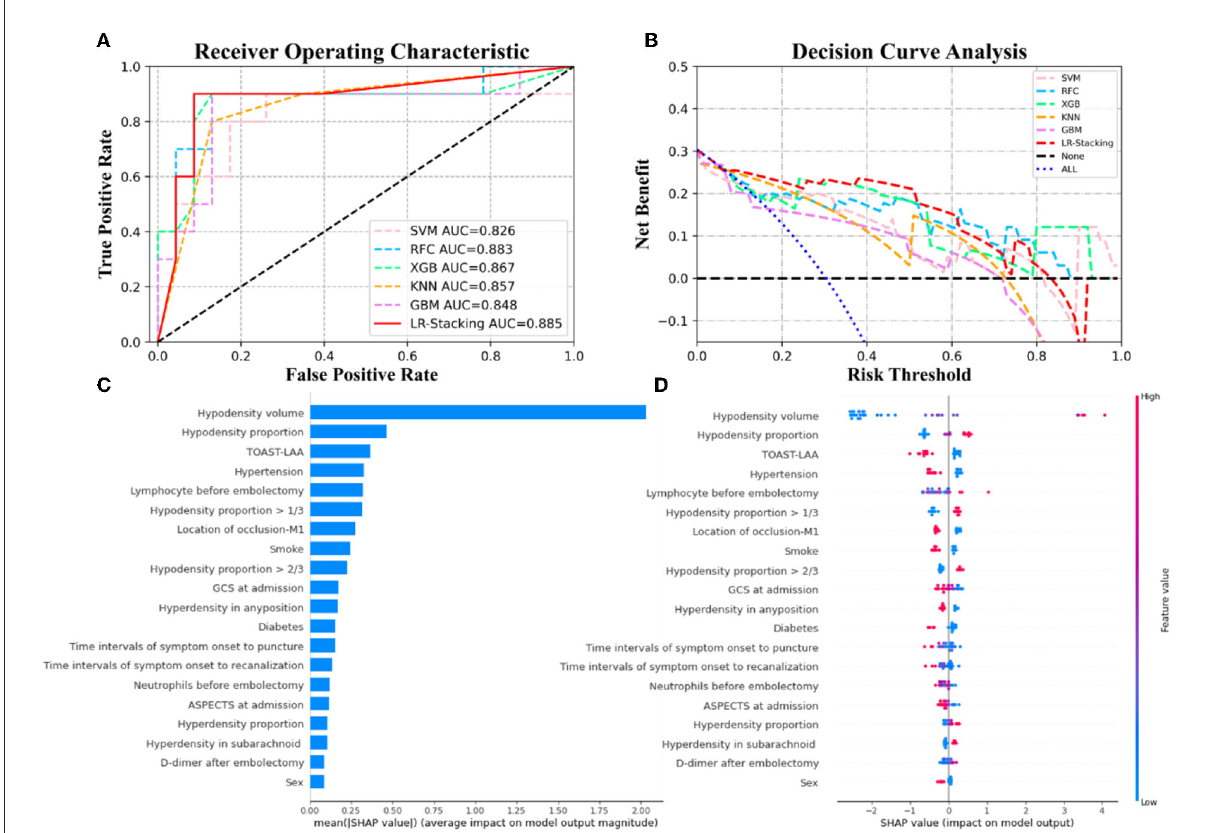
FIGURE4 The results of the ML models and the contributions of various features to predicting MCE. (A) The ROC curve of five ML models and LR-Stacking model. (B) The net benefit of the various models. (C) The importance of the features for the LR-Stacking model. (D) The effects of the features on the predictions of the LR-Stacking